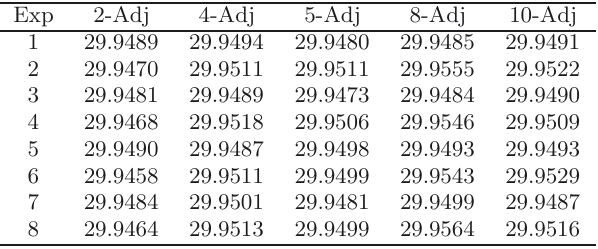
Table 3. Assemblies’ average mean ¯ μ assy , adj .